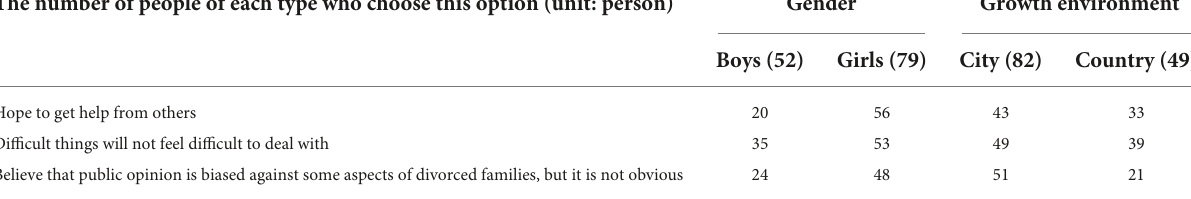
TABLE 14 Intra group comparative data on psychological demands of college students from divorced families. The number of people of each type who choose this option (unit: